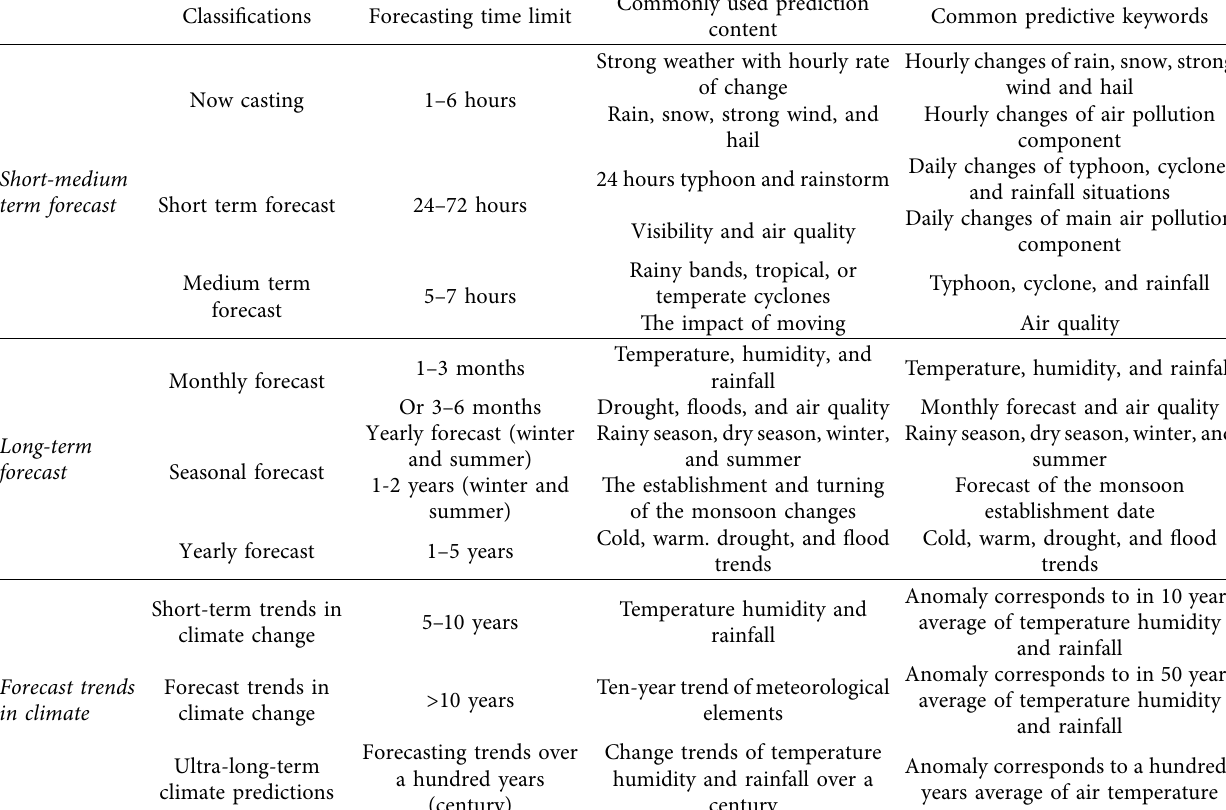
Table 1: The forecast target classifications of short-medium, long-term term, and climate trends.